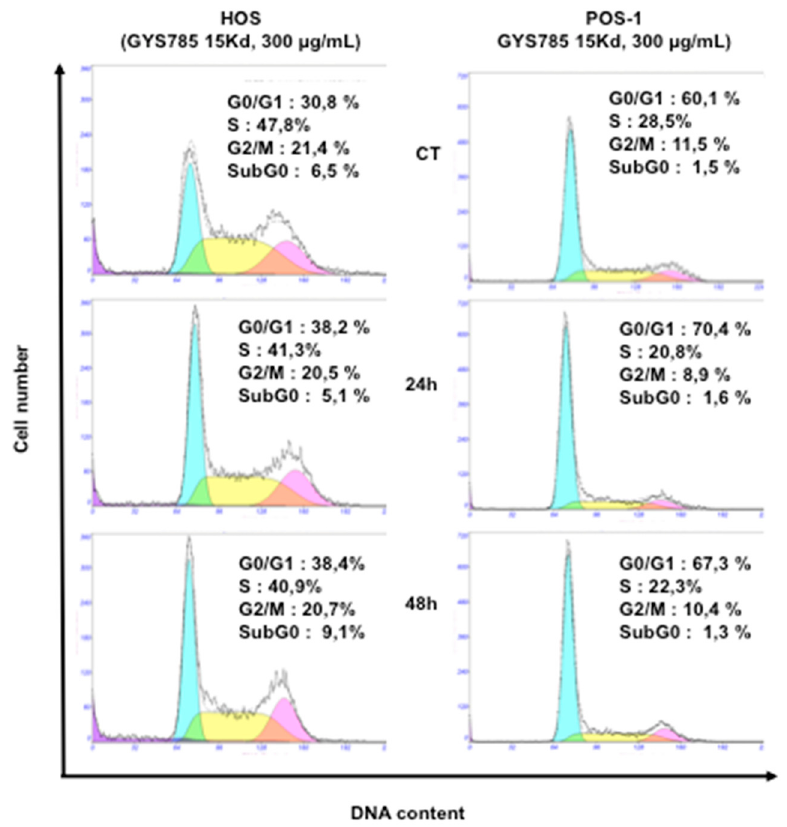
Figure 4. Effect of the OS-EPS 15 kDa derivative (300 µg/mL) on the cell cycle of osteosarcoma cell lines: cell cycle distribution of human HOS and mouse POS-1 cells were studied by flow cytometry after 24 h and 48 h treatment with OS-EPS derivatives. Experiments were repeated three times and a representative experiment is shown.